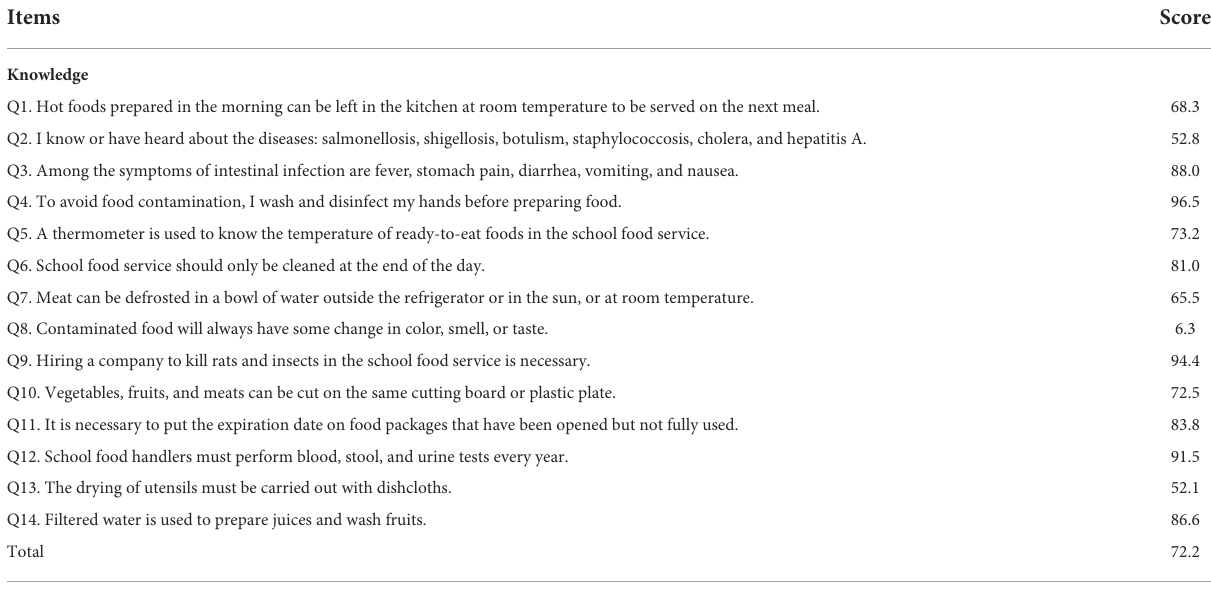
TABLE 4 The knowledge of food handlers in the School Food Services on Good Hygiene